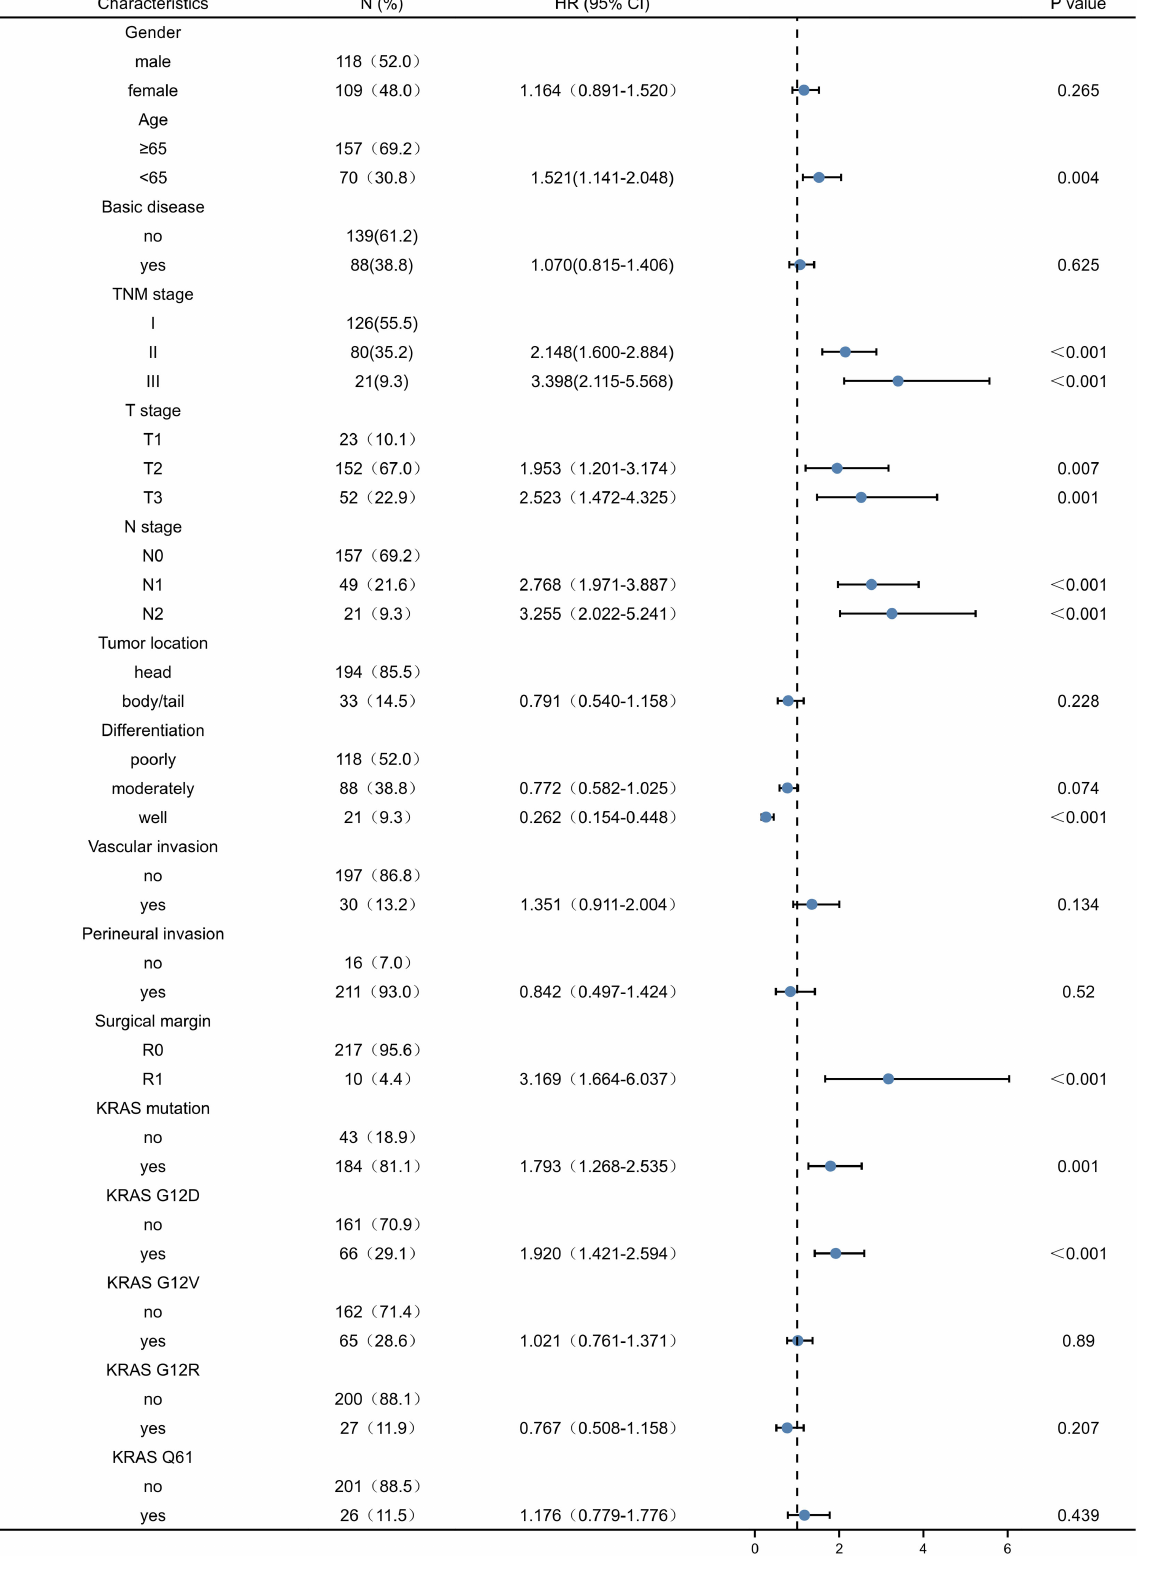
TABLE 2 Univariate analysis of factors affecting patients ‘ overall survival in pancreatic ductal